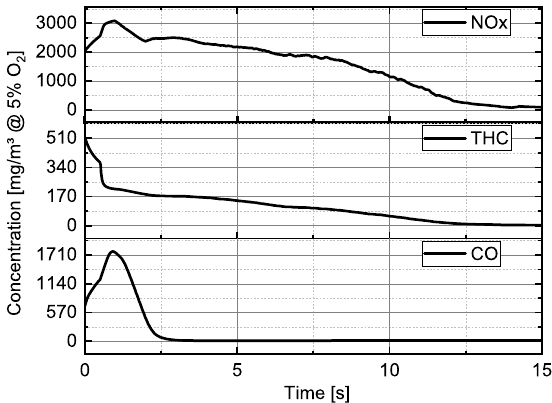
Figure 5. Downstream emission concentrations with respect to time for the reference case ( λ US _ SP = λ US _ SS ).